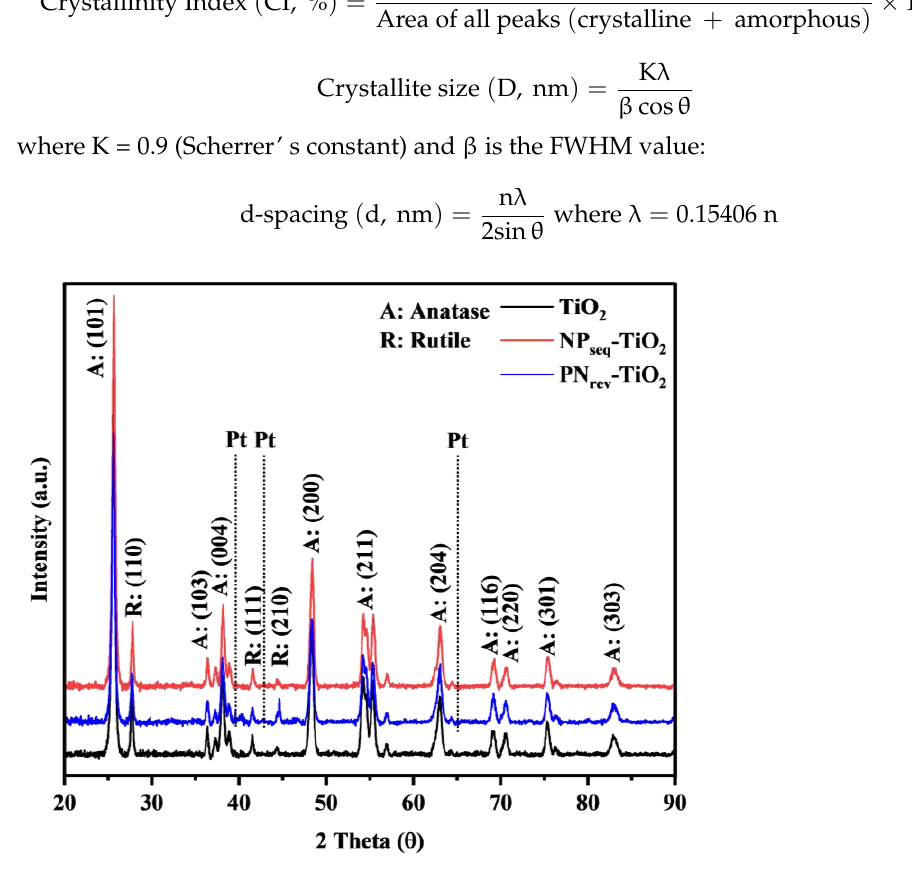
Figure 3. XRD analysis for TiO 2 , NP seq -TiO 2 , and PN rev -TiO 2 photocatalysts. Table 1. The structural properties of TiO 2 , NP seq -TiO 2 , and PN rev -TiO 2 photocatalysts.